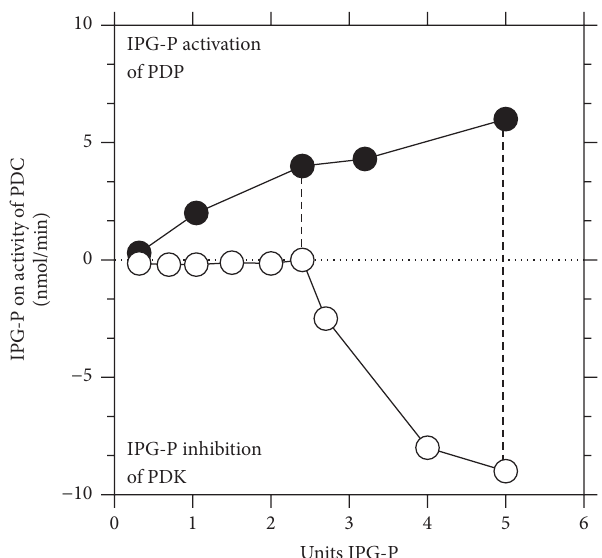
Figure 2: Inositol phosphoglycans P-type (IPG-P), which contains D- chiro inositol, can regulate the pyruvate dehydrogenase complex (PDC) by activating pyruvate dehydrogenase phosphatase (PDP) and inhibiting pyruvate dehydrogenase kinase (PDK) in a linear and sigmoid dose-dependent manner,